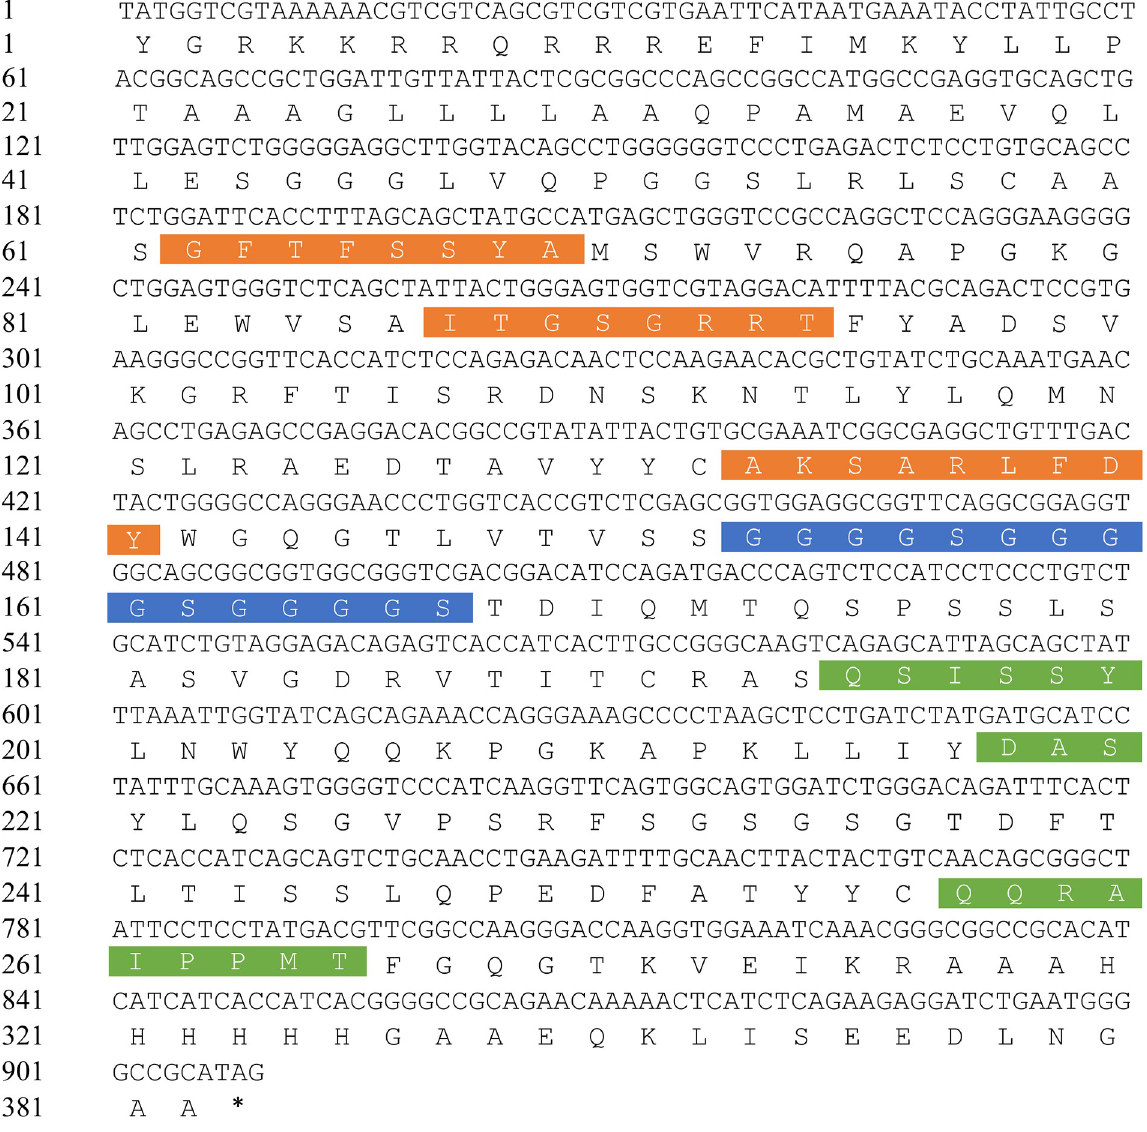
Fig 3. DNA sequence and deduced amino acid sequence. The orange sections show the variable regions CDR1, CDR2, and CDR3 of the heavy chain. The blue section is the protein peptide linker. The green section shows the variable regions CDR1, CDR2, and CDR3 of the light chain; the non-colored section is the frame